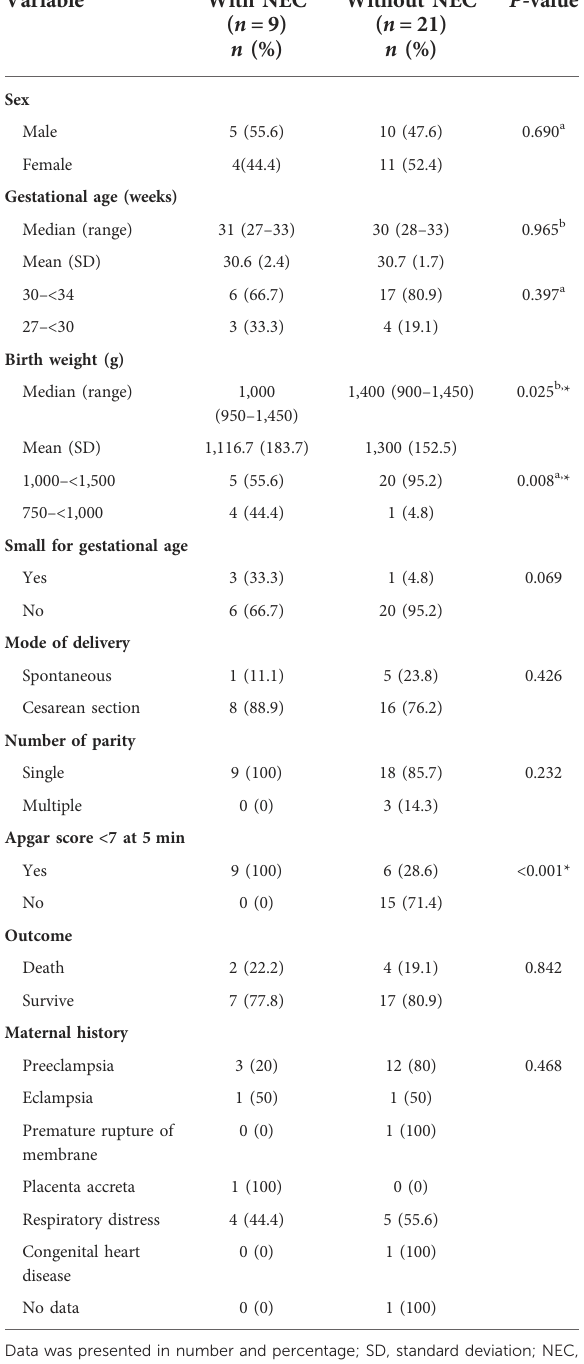
TABLE 1 Characteristics of infants with NEC and without